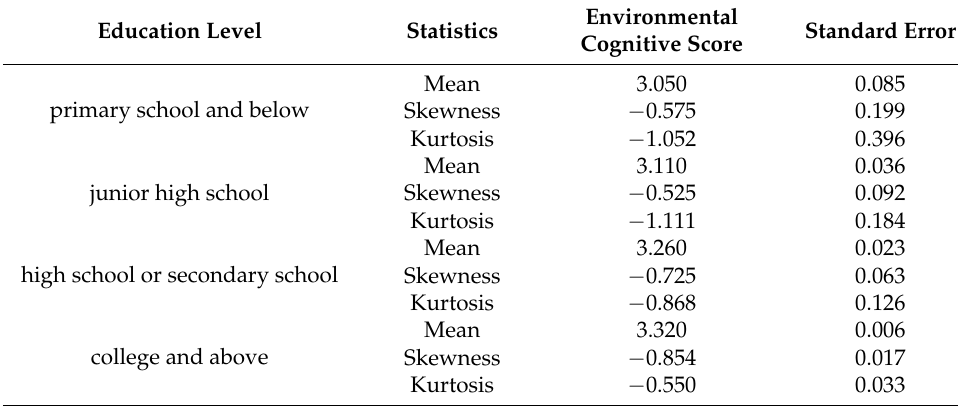
Table 2. Relationship between education level and environmental